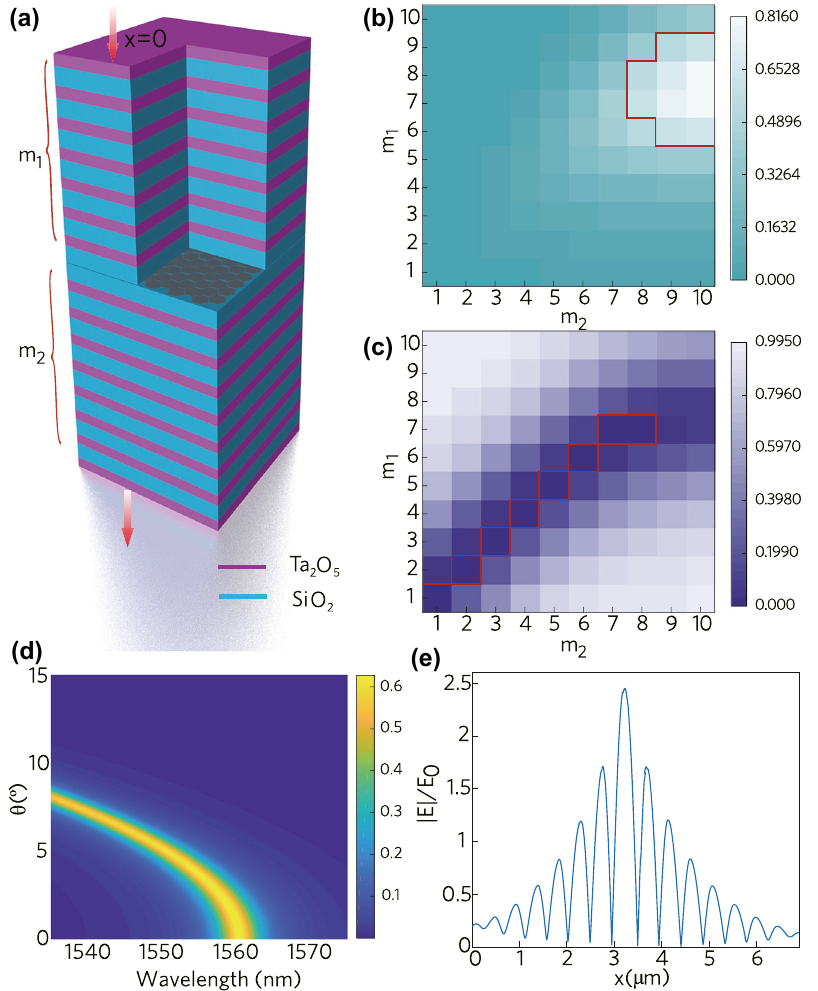
Figure 4: Finite element simulation of 1D- APCDL. (a)1D-APCDLstructuremodel,(b)–(c)absorp- tivity and reflectivity distribution map of 1D- APCDLwithdifferentperiods,(d)absorptance distribution of 1D-APCDL under different wavelengths and incident angles, (e) elec- tric field intensity distribution at different